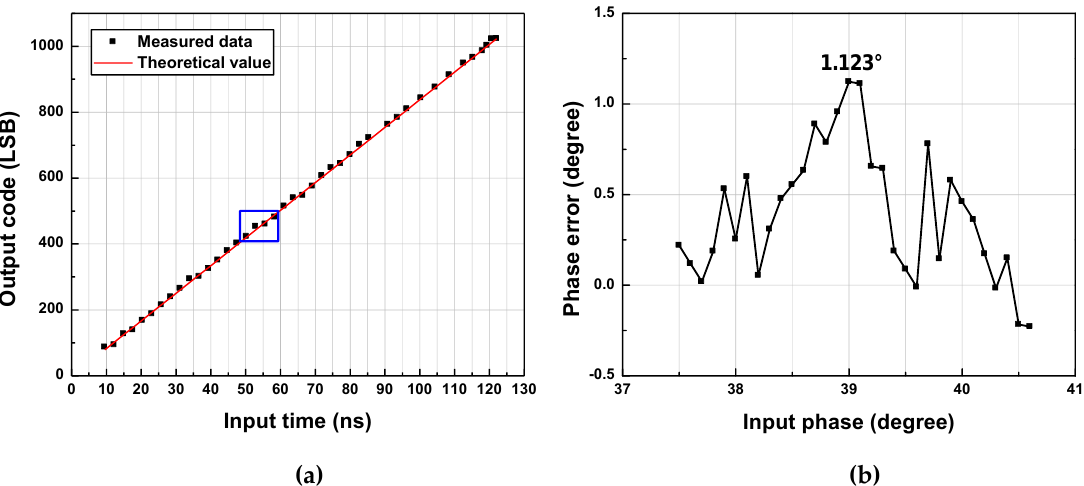
Figure 13. (a) Measured input-output characteristic of TDC, and (b) the maximum positive phase error for f in = 2.048 MHz.